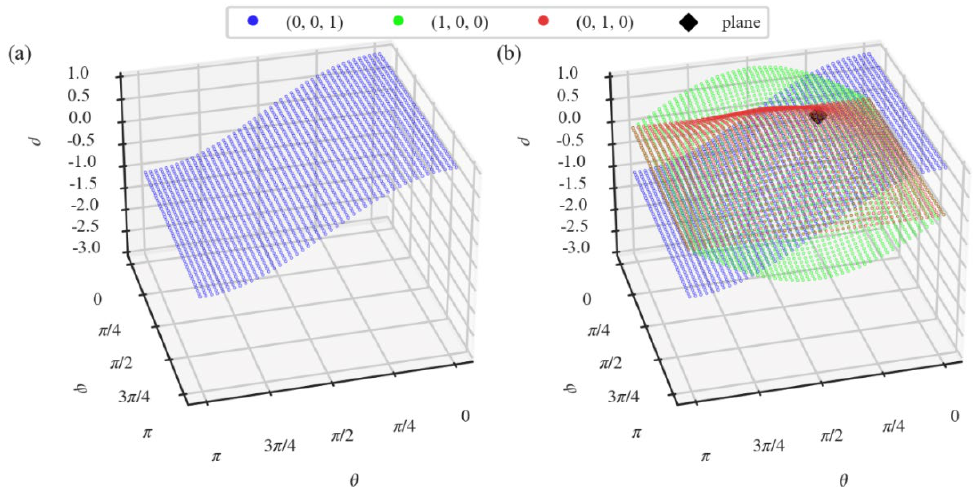
Figure 2. Transformation of three points from the Cartesian coordinate system ( x , y , z ) into Hough space ( θ , ϕ , ρ ) : ( a ) a surface corresponds to a point in the Cartesian coordinate system; and ( b ) three surfaces correspond to three points, and the black diamond intersection of the surfaces represents the plane spanning the three points.